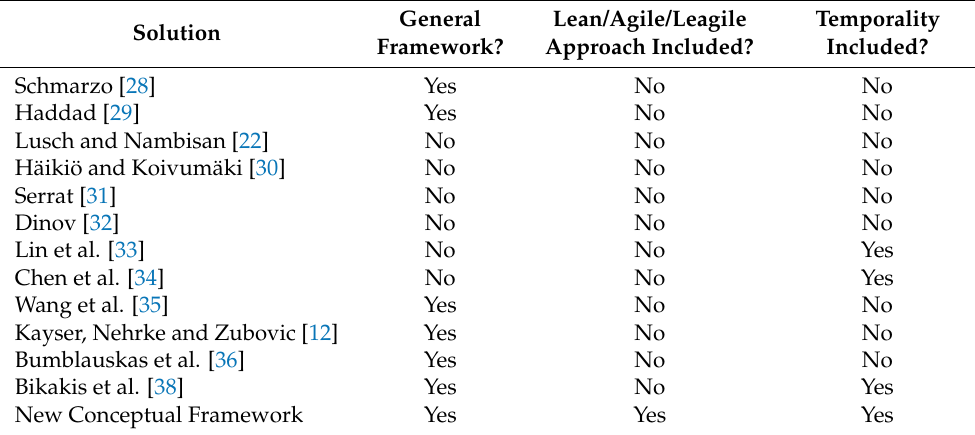
Table 1. Summary of BDA implementation